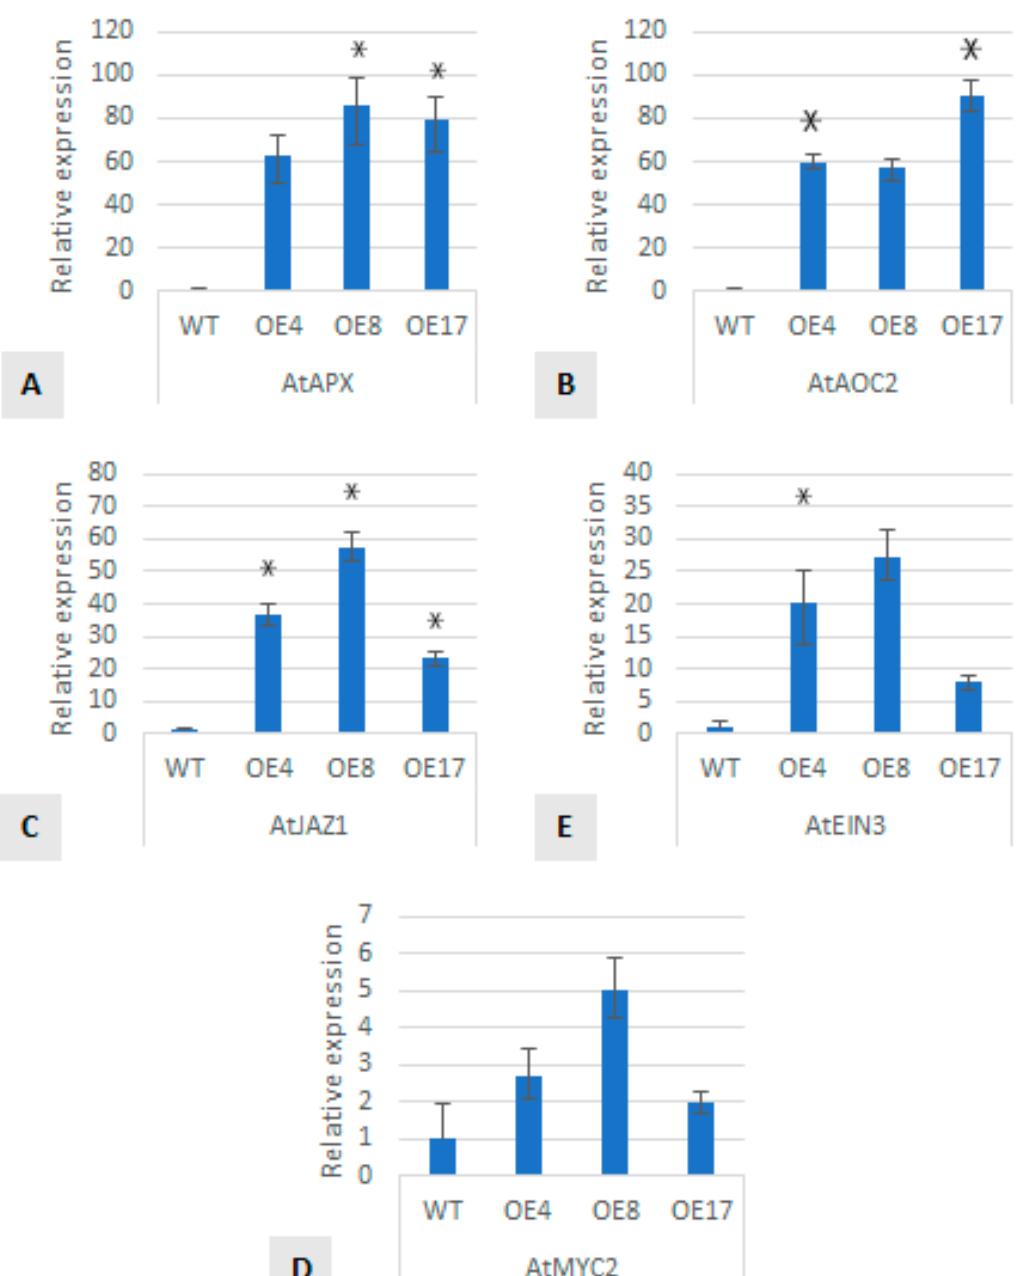
Figure 6. qRT-PCR analysis of marker genes in Arabidopsis OE lines. Relative quantification of mRNA levels of five Arabidopsis marker genes (( A ) AtAPX ; ( B ) AtAOC2 ; ( C ) AtJAZ1; ( E ) AtEIN3 and ( D ) AtMYC2 ) in the three OE lines (OE4, 8 and 17) relative to WT plants. Values are means ± standard error of three biological replicates. Statistical analyses were performed using the t -test and asterisks indicate significant differences ( p < 0.05). APX: ascorbate peroxidase; EIN3: transcription factor EIN3; JAZ1: jasmonate ZIM domain; AOC2: allene oxide cyclase 2; MYC2: helix-loop-helix DNA-binding family protein.